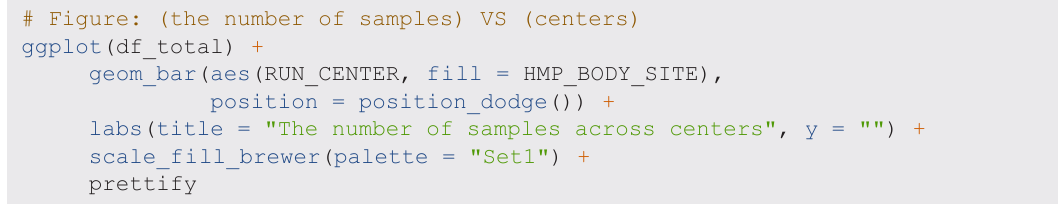
# Figure: (the number of samples) VS (centers)